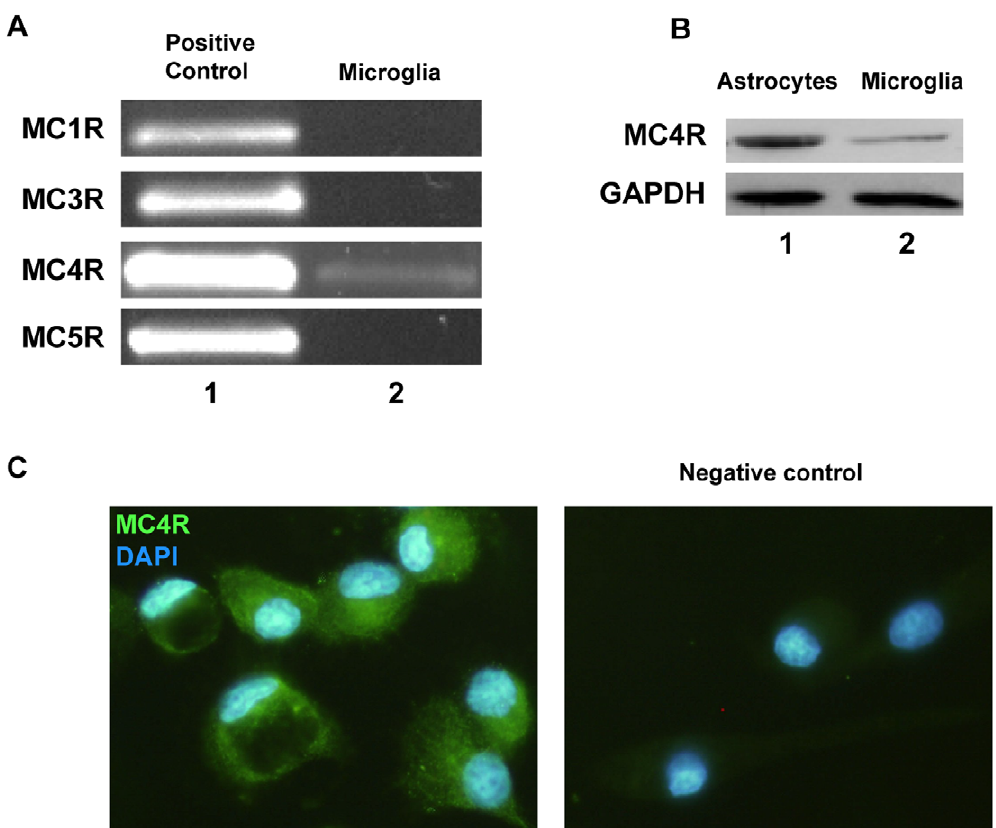
Figure 1. Melanocortin 4 receptor expression in rat microglia. (A) MCR mRNA expression was assessed by RT-PCR using total mRNA from untreated microglial cells. Genomic DNA was used as a positive control (lane 1). A band close to 595 pb corresponding to MC4R amplification product was detected in primary cultured microglial cells (lane 2, MC4R). We did not detect expression of the other MCR subtypes in these cells (lane 2). (B) MC4R protein expression was evaluated by western blot. Total protein sample from astrocytes was used as a positive control. Results show the presence of a band of nearly 50 KDa in both astrocytes (lane 1) and microglia (lane 2). (C) MC4R was detected in primary microglia by immunocytochemistry. The left panel shows MC4R immunoreactivity in microglial cells. Nuclei were stained with DAPI to identify individual cells. The negative control is shown in the right panel.